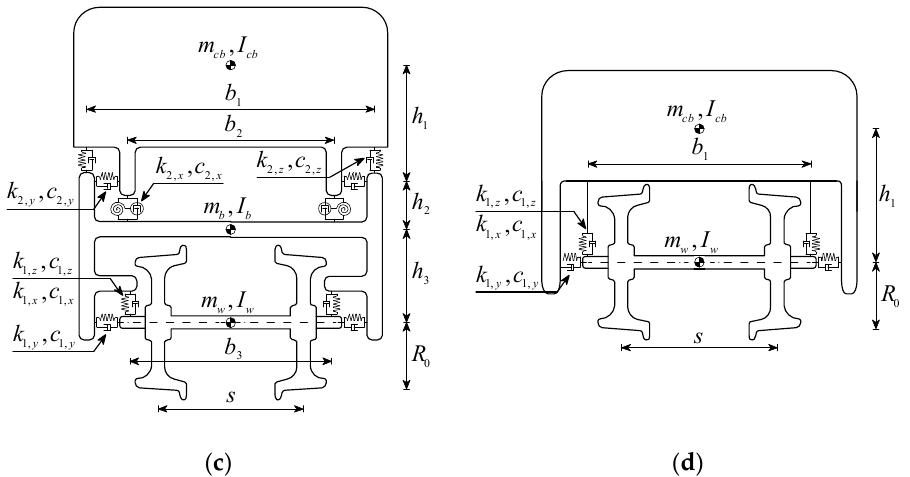
Figure 1. Dynamic models of the railway vehicles: lateral views of the ( a ) Alfa Pendular and ( b ) freight wagon, and front views of the ( c ) Alfa Pendular and ( d ) freight wagon. Table 1. Parameters for the Alfa Pendular vehicle (adapted from Neto et al. (2020) [39]).